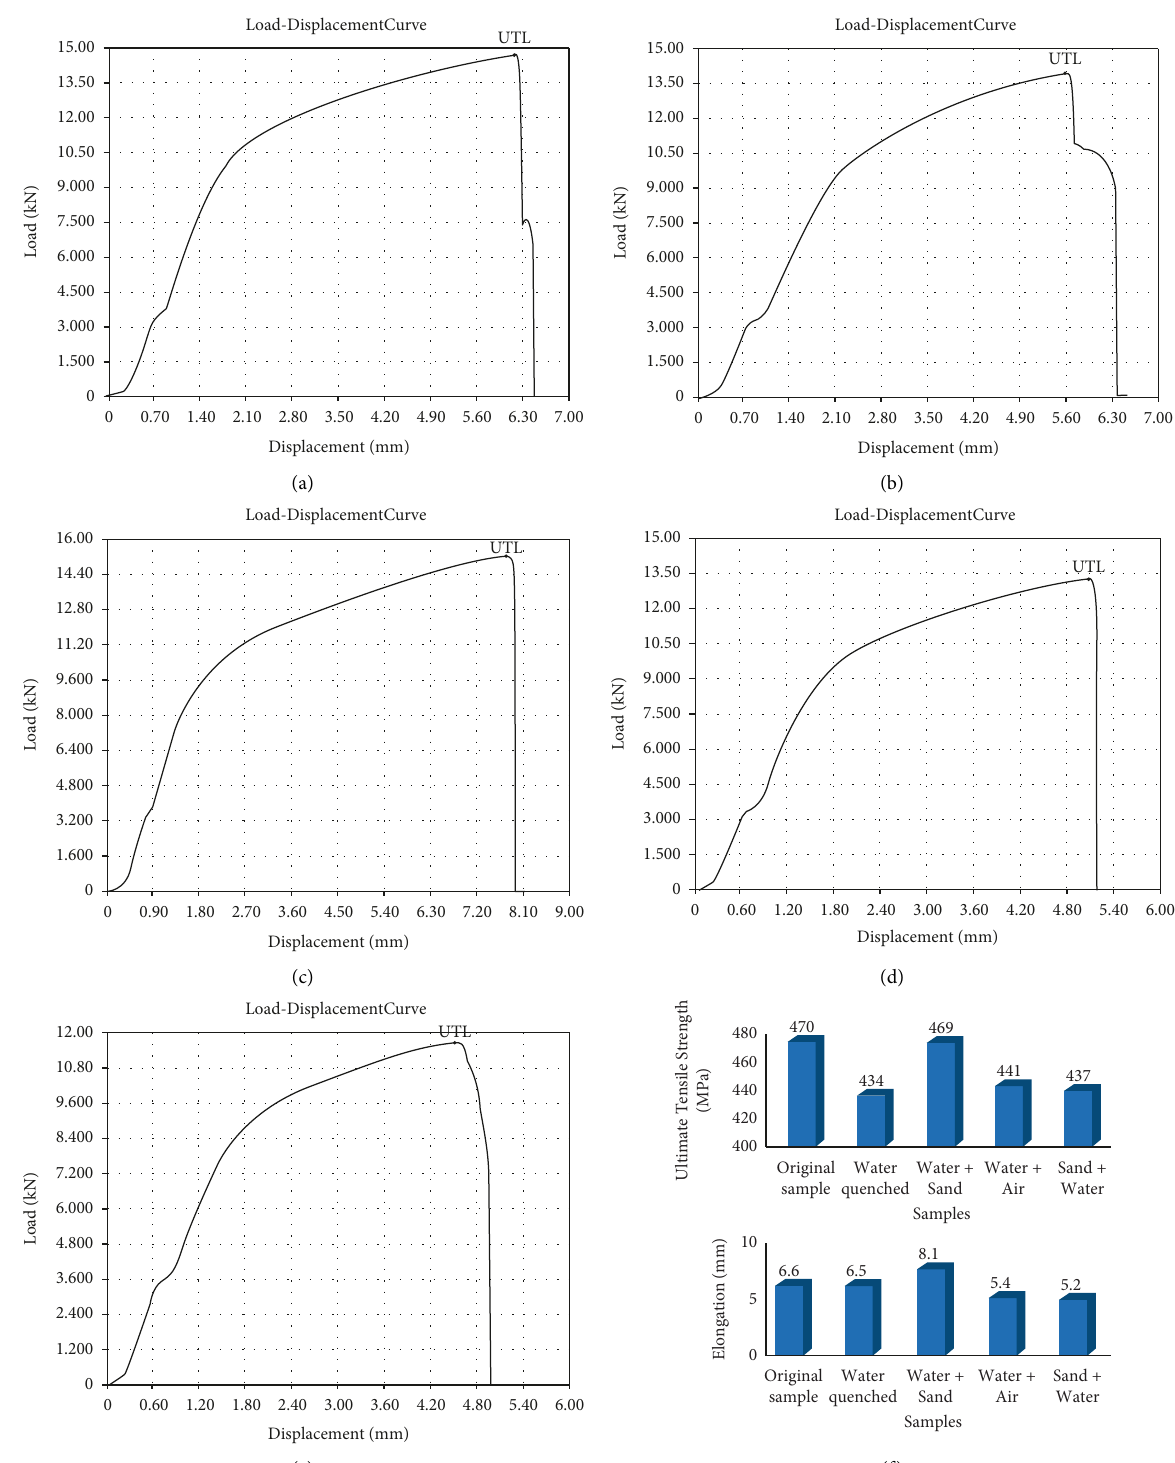
Figure 10: Load vs. displacement graphs of fve specimens: (a) sample 1 (original sample); (b) sample 2 (water-quenched sample); (c) sample 3 (water+sand-cooled); (d) sample 4 (water+air-cooled); (e) sample 5 (sand +water-cooled); (f) the comparative bar chart of UTS and